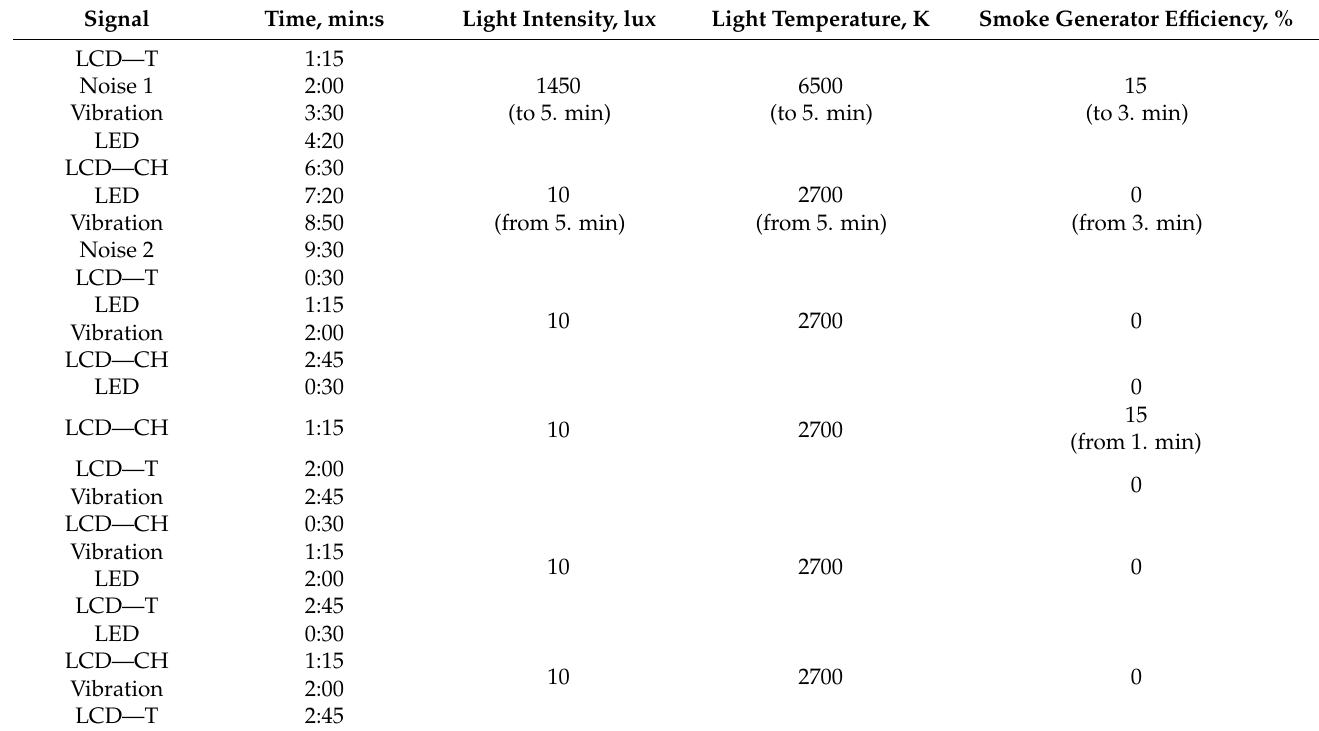
Table 3. Schedule of the experiment at individual